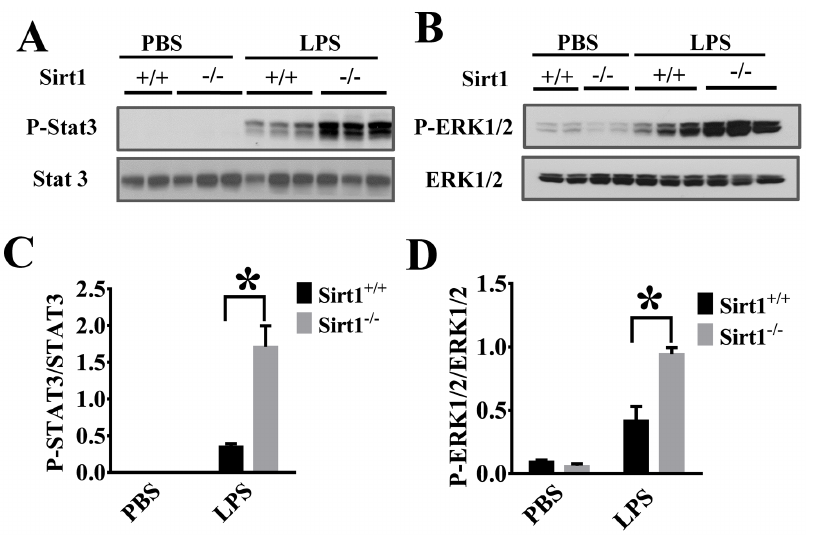
Figure 6. Sirt1 deletion enhances LPS-induced Stat3 and ERK1/2 activation in the kidney. Kidney tissues were harvested 6 h after LPS challenge (n $ 7 mice/group). Samples were subjected to immunoblotting assay. STAT3 (A) and ERK1/2 (B) phosphorylation were examined in the kidney tissues by immunoblotting assay. (C, D) Densitometry analysis. *P , 0.05 versus Sirt1 + / + /LPS group.